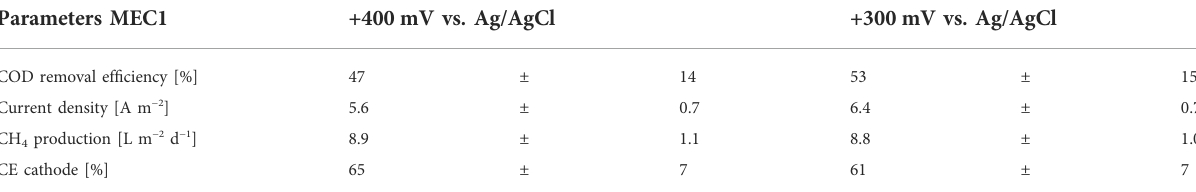
TABLE 3 Comparison of monitored parameters of MEC1 — COD removal ef fi ciency, current density, CH 4 production and CE cathode. Parameters